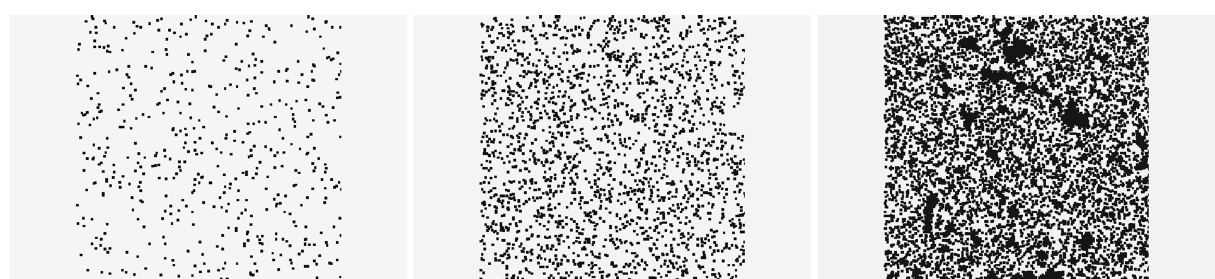
Figure 1. The exemplary pore-scale velocity magnitude in the fluid flow calculated using the LBM based on configurations from Fig. 2—brighter the color larger velocity. Contrast and brightness are adjusted to visualize the structure of emerged flow paths.